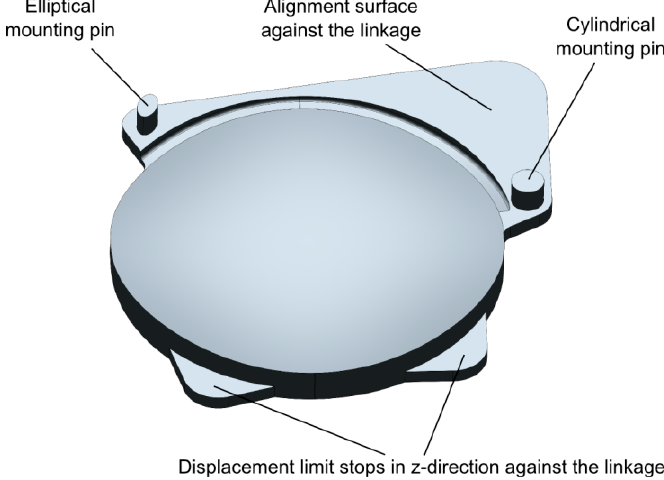
Figure 3. Computer Aided Design (CAD) model of one of both identical lens parts of the AH optics with alignment structures indicated [1].